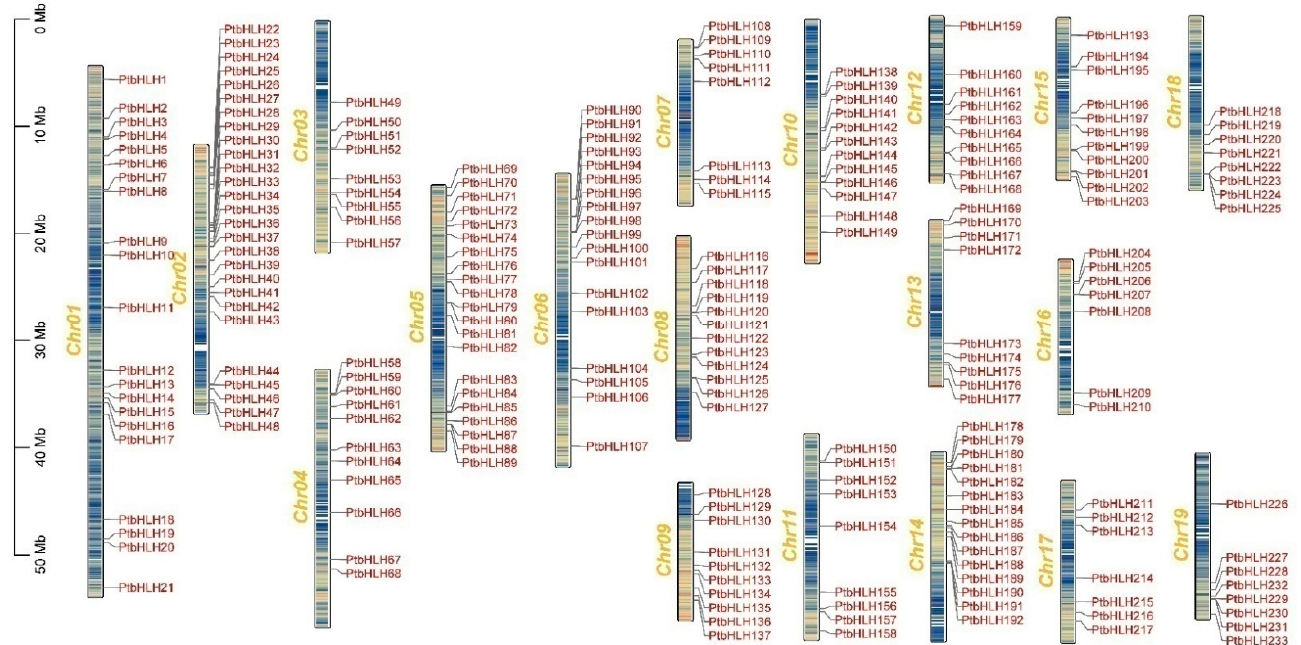
Figure 1. Chromosomal locations of bHLH gene family in poplar. Chromosome numbers are shown at the left of the chromosomes. bHLH genes are labeled at the right of the chromosomes. Scale bar denotes the chromosome lengths (Mb).